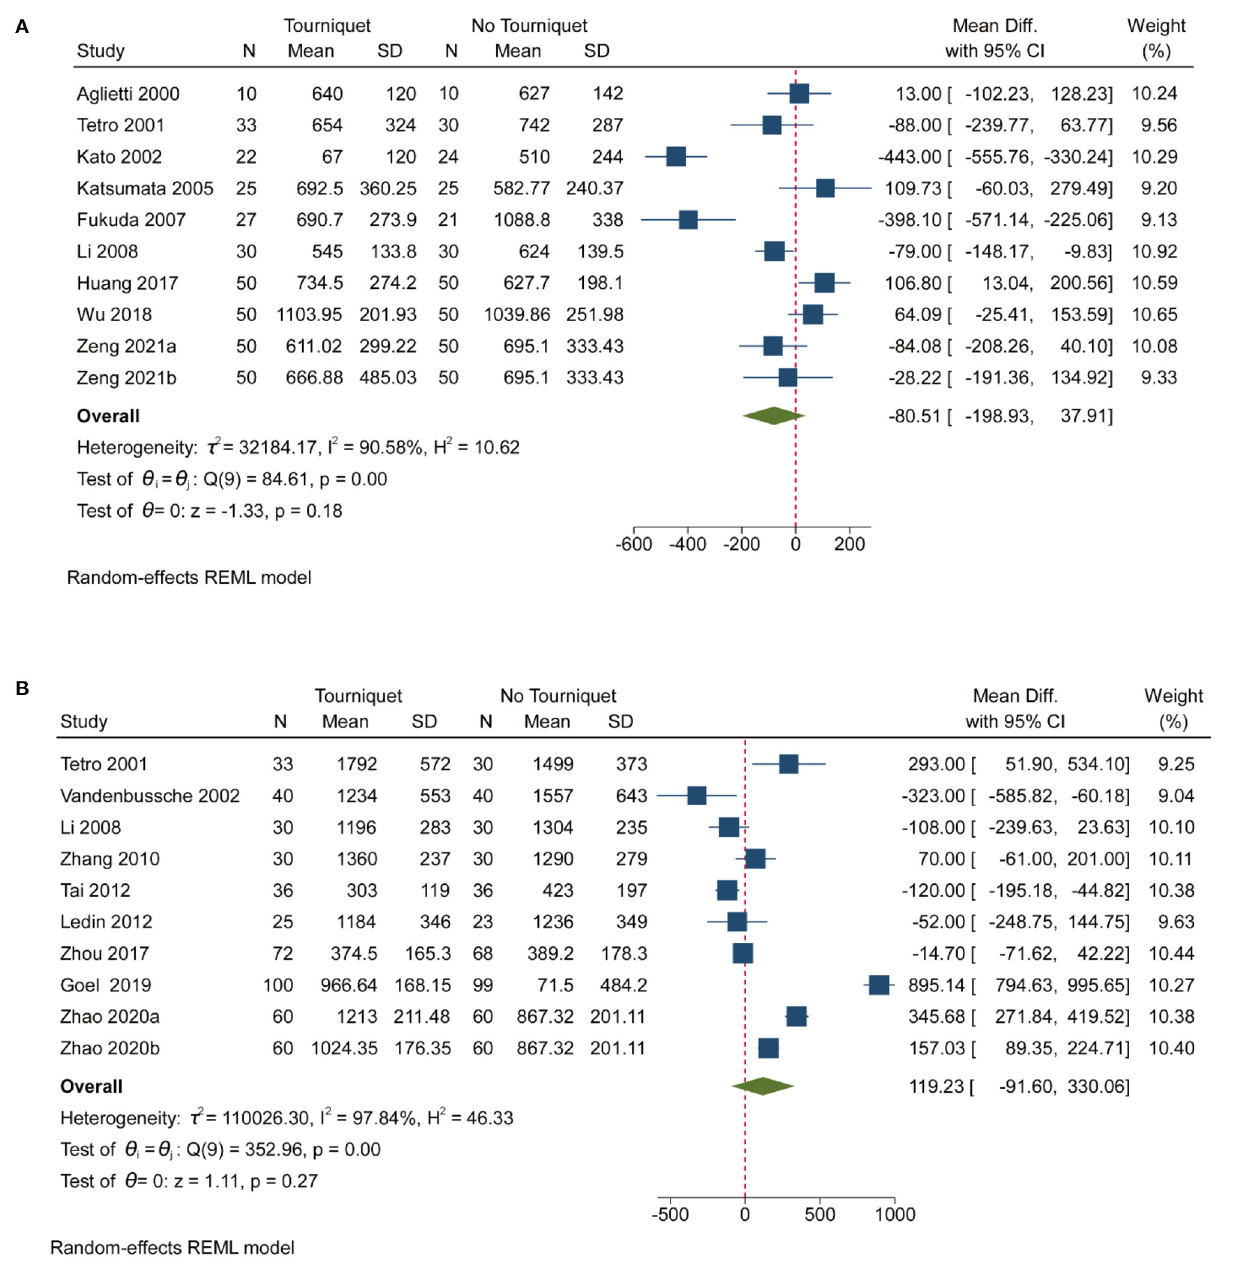
deviations in the publication. More than 50%